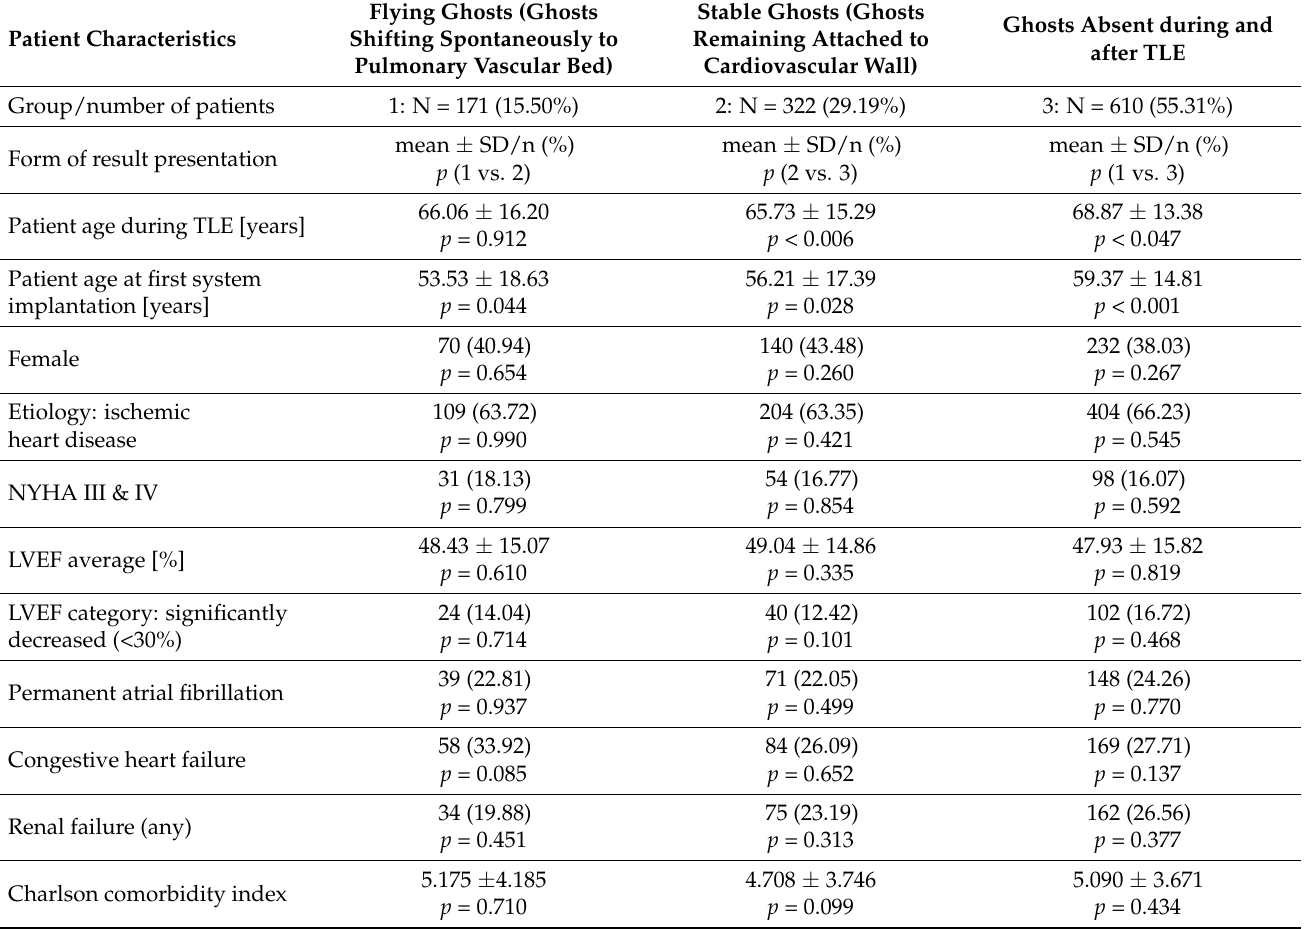
Table 1. Patient characteristics and comparison of potential patient-related risk factors for the occurrence of both forms of